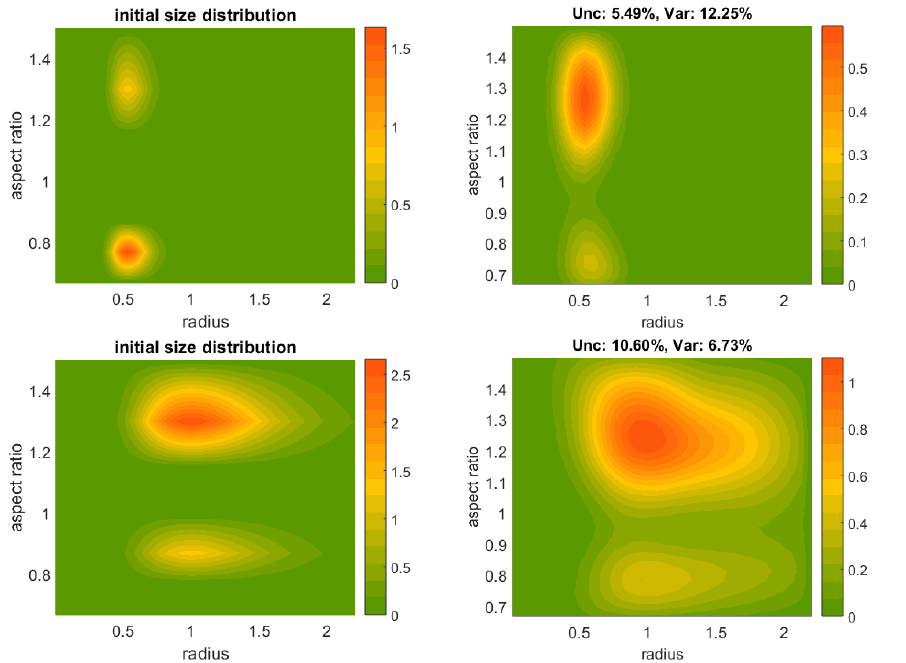
Figure 7. Reconstructions of bimodal shape-size distributions with two distinct aspect-ratio modes. Right: reconstructions corresponding to the cases 5 (top) and 6 (bottom) from Table 3. Left: Initial shape-size distributions for the reconstructions on the